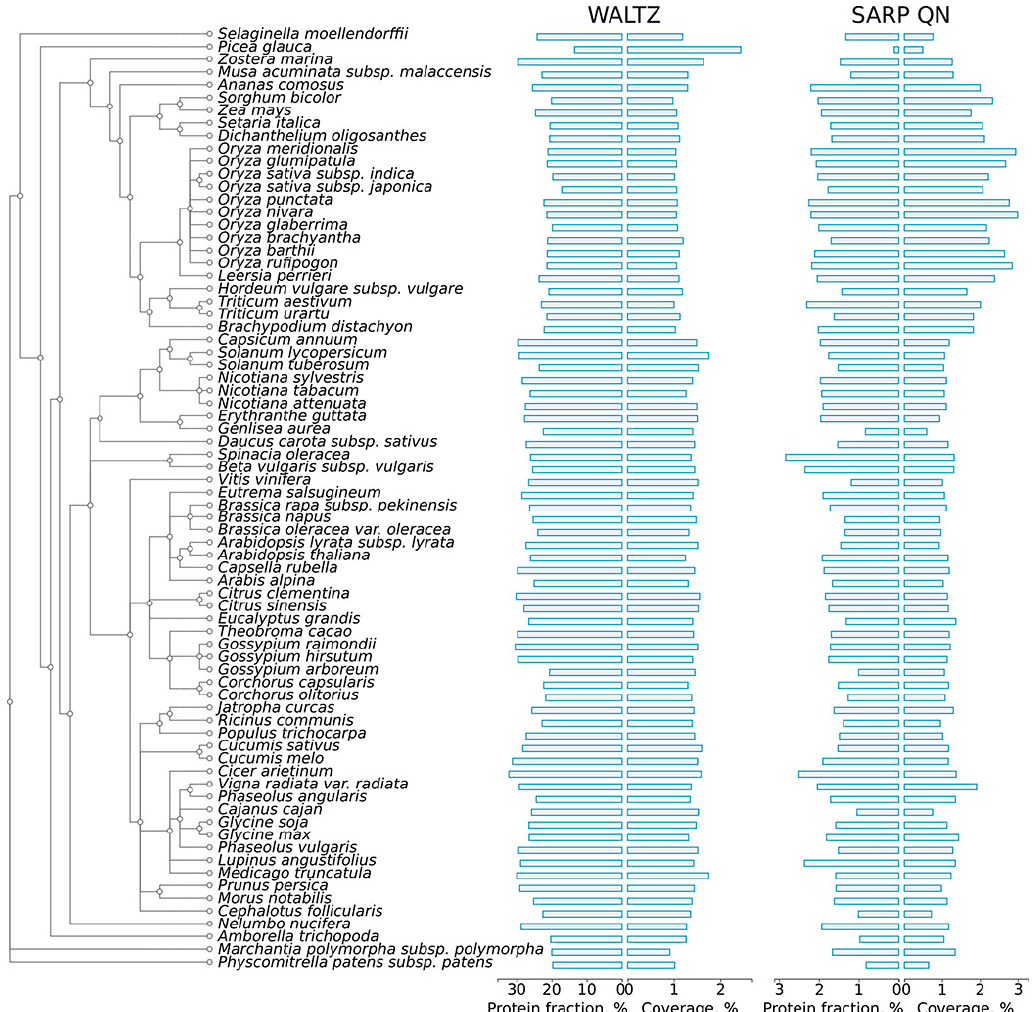
Figure 1. Distribution of amyloidogenic regions in the proteomes of land plants. A phylogenetic tree of plant species is shown according to the Uniprot Taxonomy. The results for proteins bearing ARs predicted by Waltz and QN-rich CBRs found with SARP are shown. For each type of amyloidogenic region, the percentage of proteins harboring these regions (%) and the coverage of the total proteome length with these regions (%) are shown. ARs, amyloidogenic regions; Q, glutamine; N, asparagine; CBRs, compositionally biased regions; SARP, Sequence Analysis based on the Ranking of Probabilities